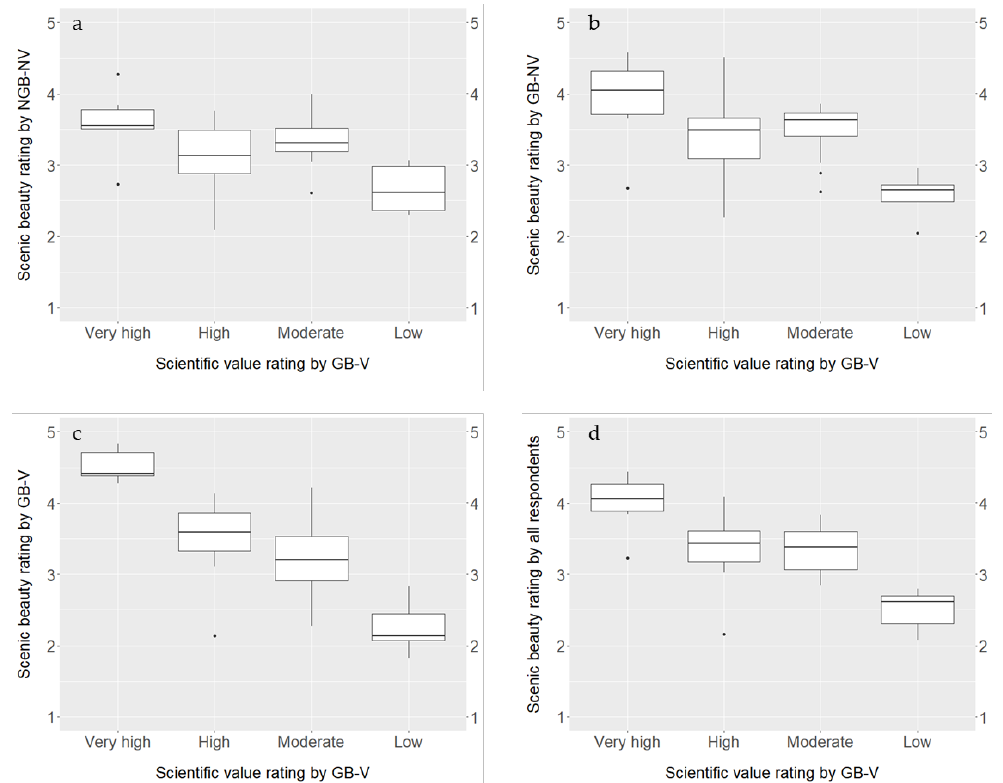
Figure 5. ( a – d ) Boxplots of scenic beauty rating by respondents, grouped following their geoscience background and field visits (NGB-NV = no geoscience background no visit to geosites, 104 persons; GB-NV = geoscience background and no visit to geosites, 43 persons; GB-V = geoscience background and visit to geosites, 29 persons), for different scientific value ratings. Scientific value was rated by the GB-V group (29 persons) on a 1–5 scale. This scientific value rating of geosites was then grouped based on mean scientific value rating: Very high = 4.0 and above (6 geosites); High = 3.5–3.9 (11 geosites); Moderate = 3.0–3.5 (12 geosites); Low = below 3.0 (5 geosites). The scientific value rating was done by the GB-V group, 29 persons (see Table A5 in Appendix A). “Scenic beauty rating by all respondents” is the mean scenic beauty rating of the three respondent